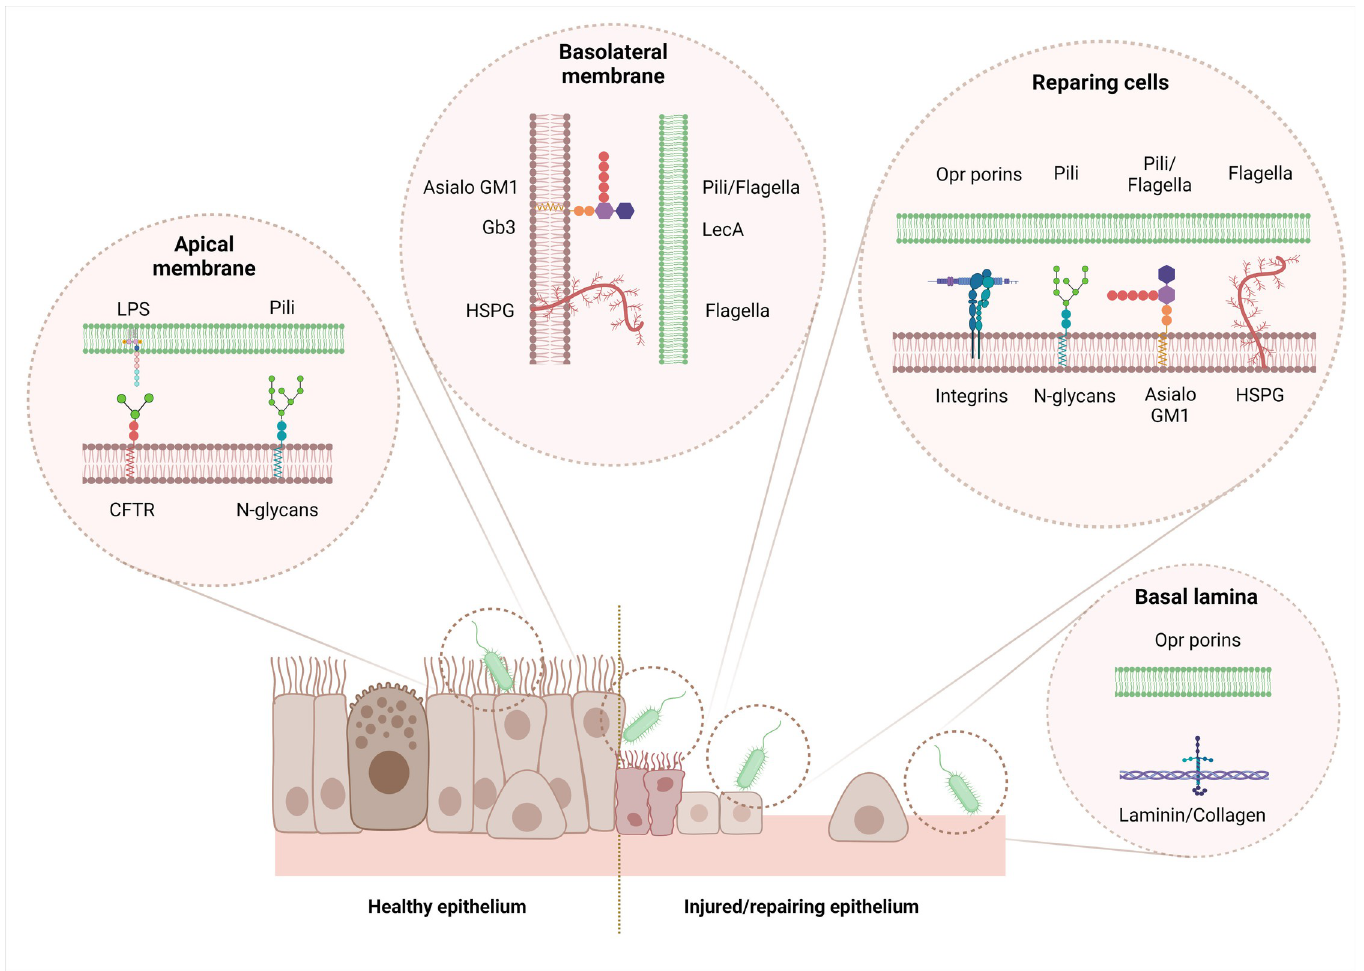
Fig 3. Airway receptors of P . aeruginosa . Green membrane: P . aeruginosa ; brown membrane: host cells. Created with BioRender.com.